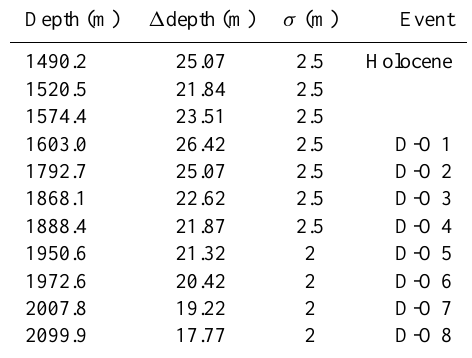
Table 3. New (cid:49) depth markers of NGRIP deduced from the data of Kindler et al.